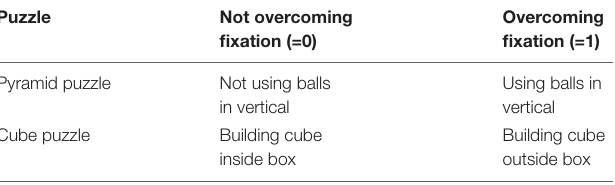
Overcoming fixation (=1) Using balls in vertical